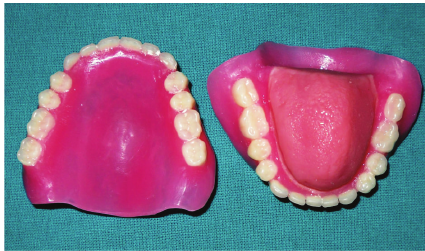
Figure 11: Final tongue prosthesis.